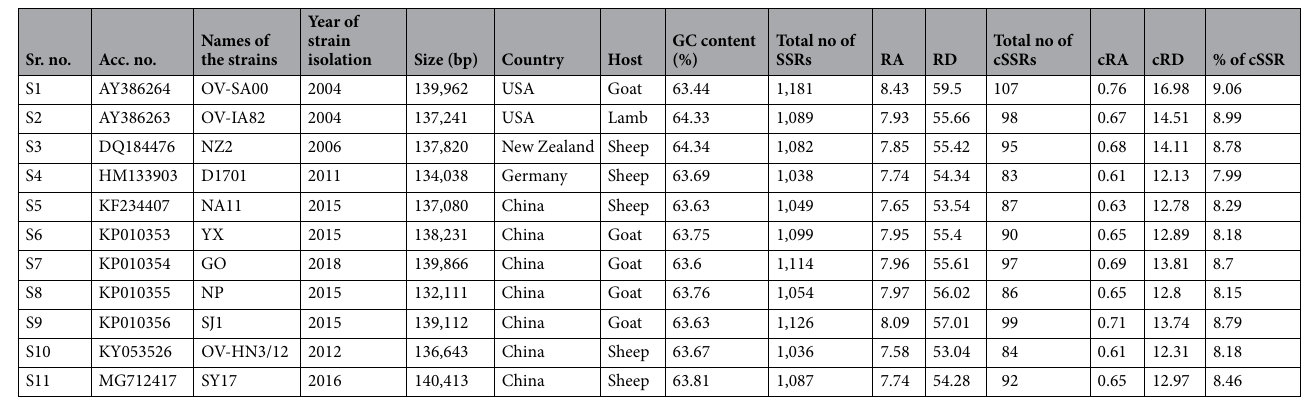
Table 1. Overview of microsatellites in ORFV complete genome